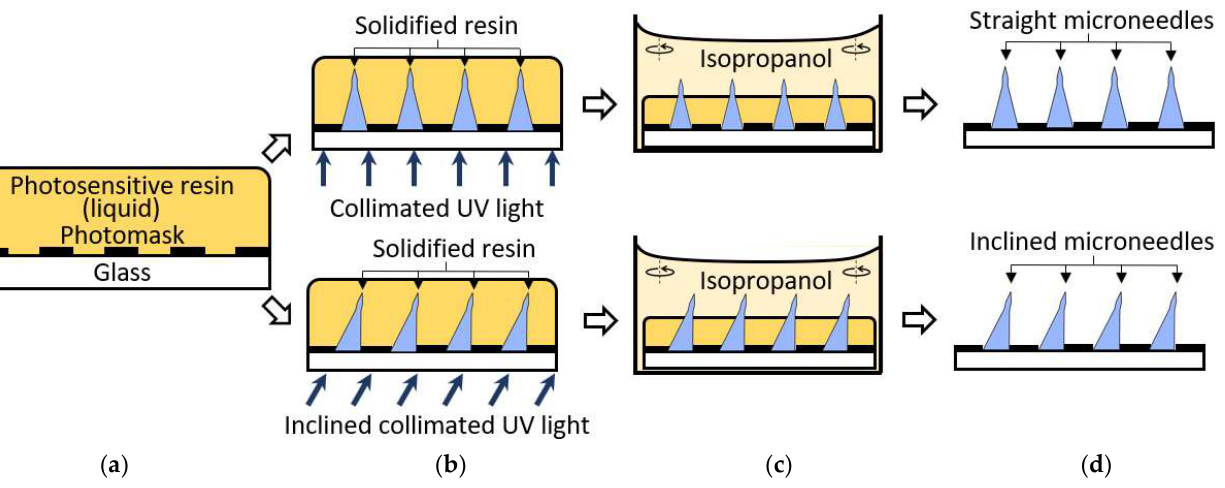
Figure 3. Straight and inclined microneedles fabrication process. ( a ) Photosensitive resin coated on the photomask. ( b ) Backside UV exposure. ( c ) Develop resin in isopropanol with slight agitation. ( d ) Microneedles array complete.